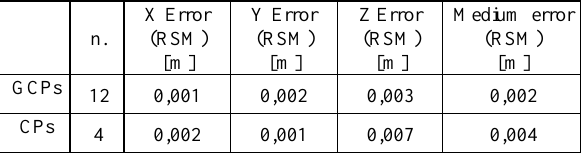
Table 1. Very high accuracy of the three types of oriented images blocks.